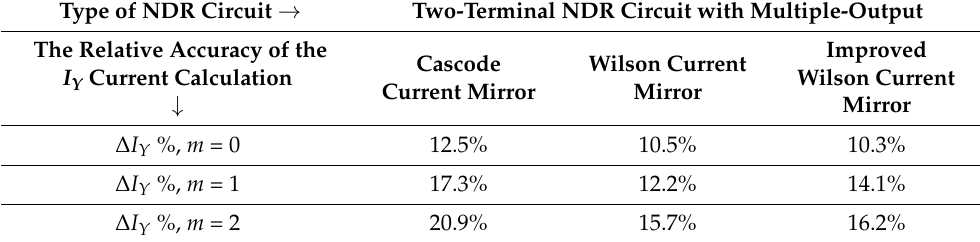
Table 6. The relative accuracy of the I Y current calculation for different two-terminal NDR circuits ( T 0 —PHEMT).